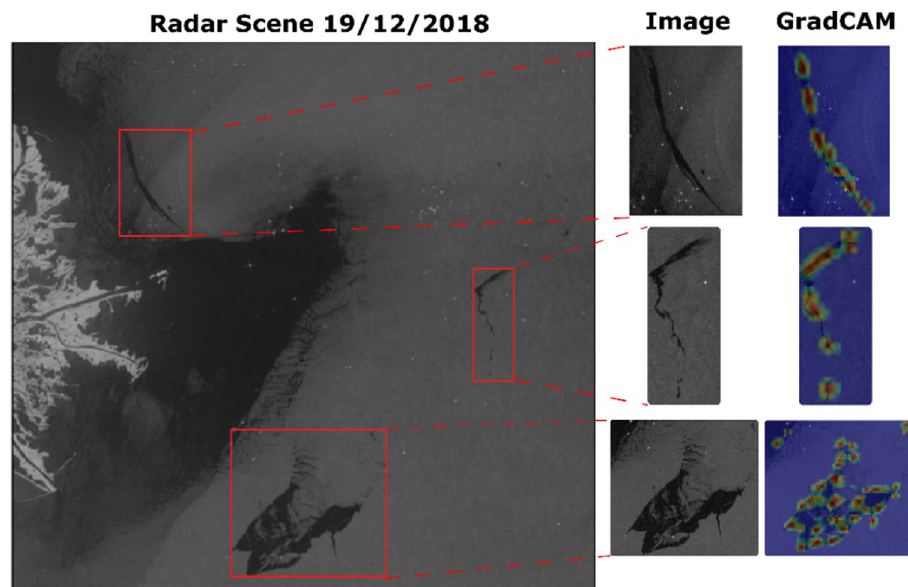
Fig. 14 Grad-CAMs produced by DAS with images from the Oil Spill dataset (24/02/2020) for class Oil. Only the patches predicted by the model as belonging to this class are